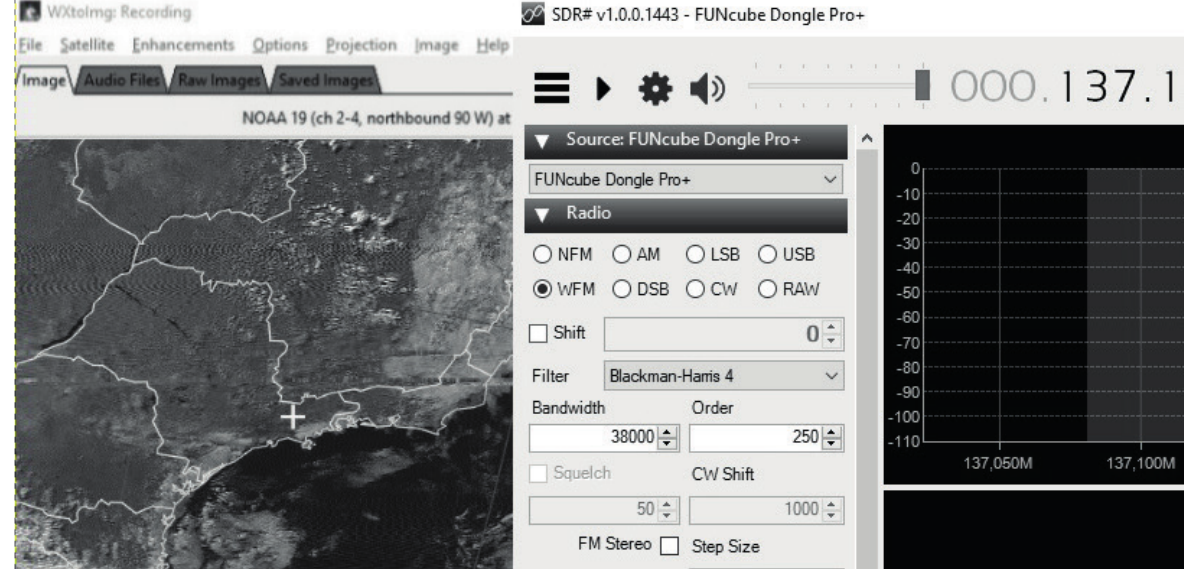
Figure 5 - SDRSharp and WXtoImg working for image